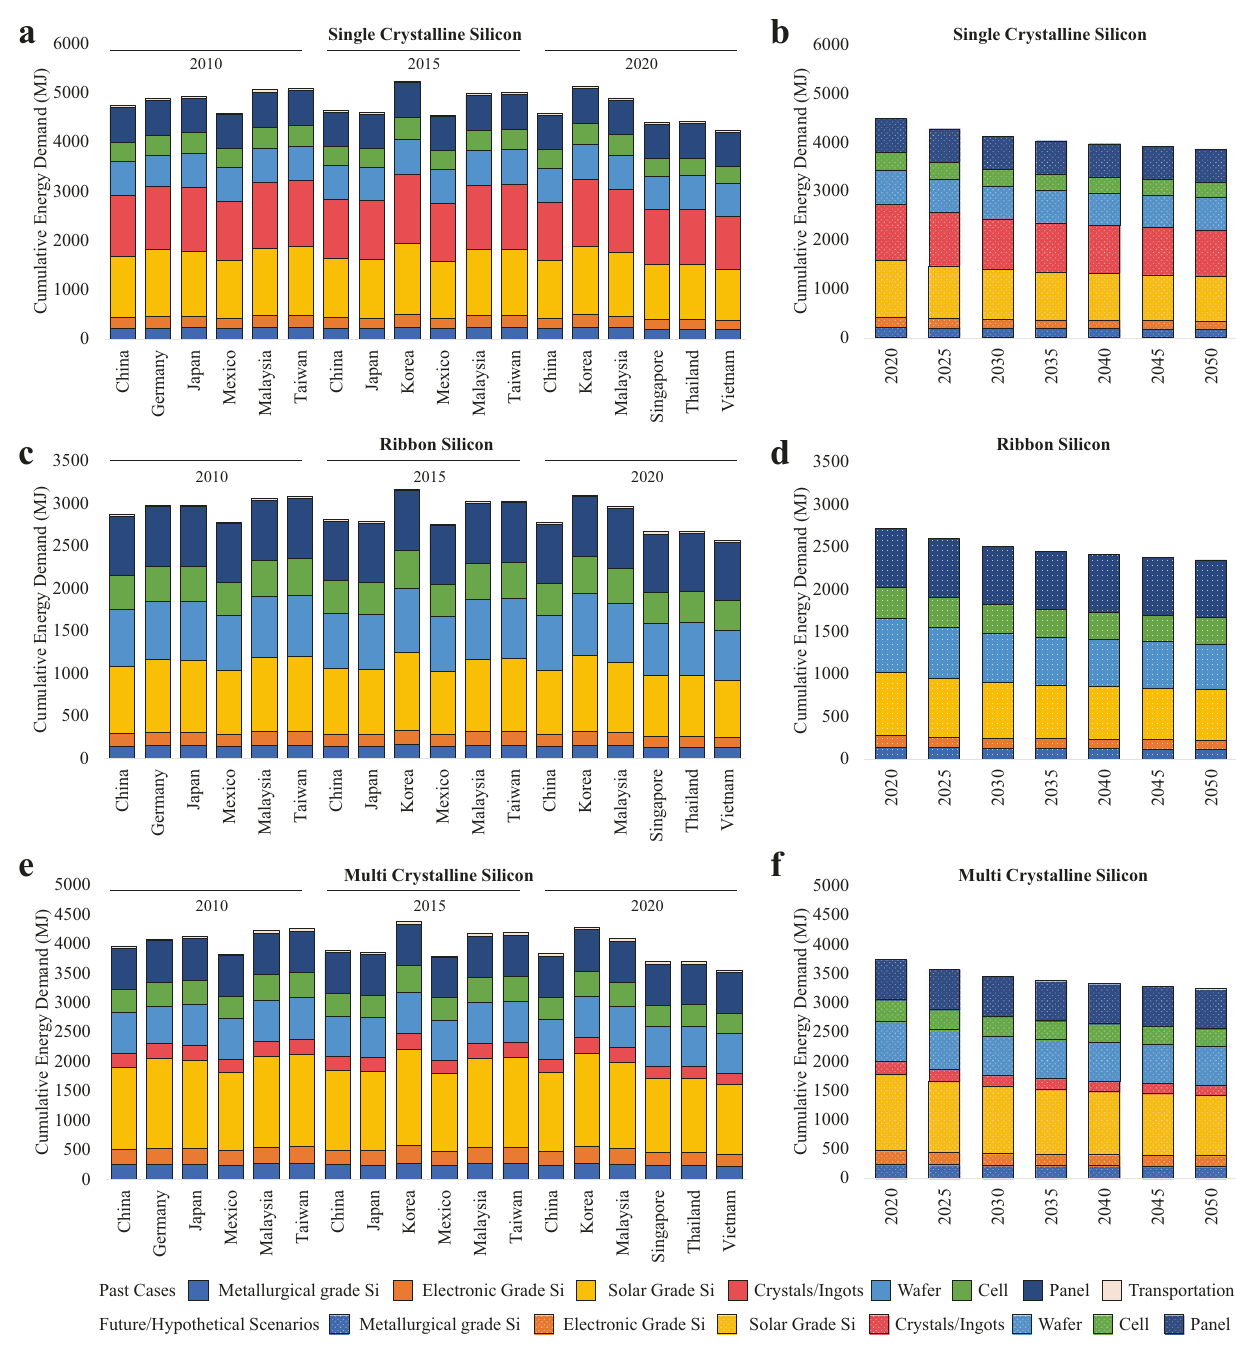
Fig. 3 | Cumulative energy demand of crystalline silicon photovoltaic (PV) panel supplies to the U.S., with the breakdown of climate change impacts of each individualmanufacturing stageand transportation. Results are presented for ( a ) single-crystalline silicon (sc-Si) PV in offshore cases, ( b ) sc-Si PV in reshored scenarios, ( c ) ribbon silicon (r-Si) in offshore cases, ( d ) r-Si in reshored scenarios, ( e )multi-crystallinesilicon(mc-Si)inoffshorecases,aswellas( f )mc-Siinreshored scenarios. Reshored manufacturing scenarios in ( b , d , and f ) illustrate the down- ward energy consumption trend over time, whereas offshore manufacturing cases